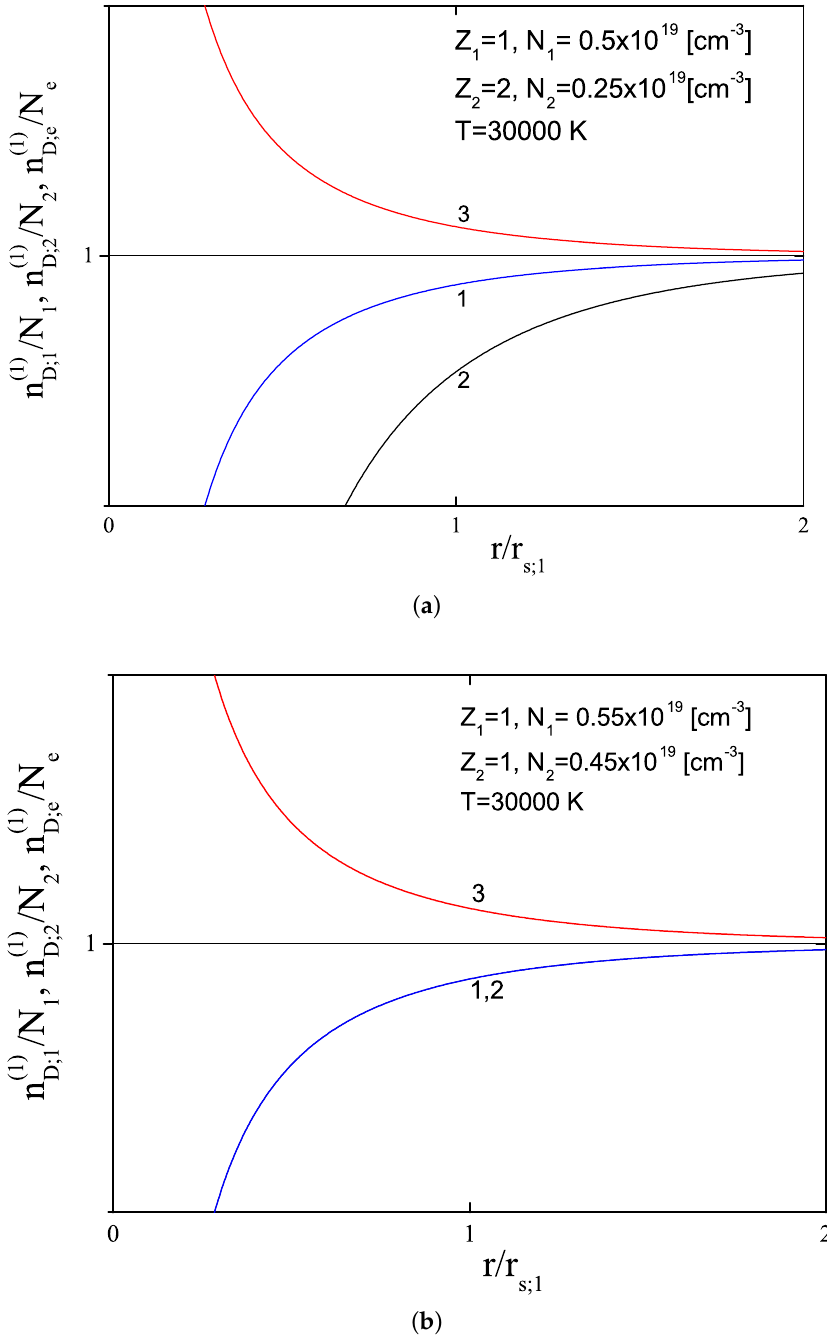
( 1 ) ( 1 ) ( r ) / N ( r ) / N 2 1 (curve marked with 1), n D ;2 D ;1 ( 1 ) ( r ) / N e (curve marked with 3) in the case of Z = 1, Z = 2 and 2 1 D ; e ( 1 ) ( r ) / N 1 (curve marked with 1), D ;1 ( 1 ) ( r ) / N e (curve marked with 3) in the case of Z = Z = 1 2 1 D ; e